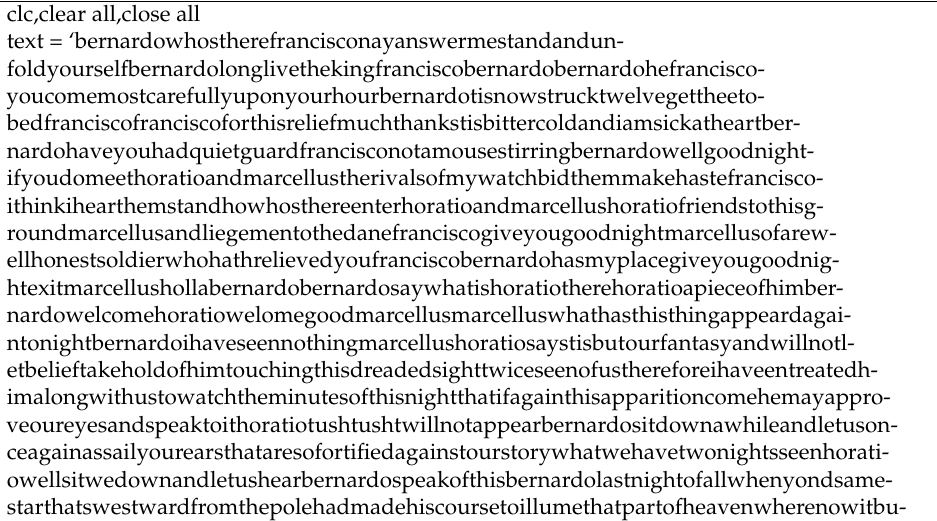
Table A1. Pattern generation code of the text-based feature generation methodology. clc,clear all,close